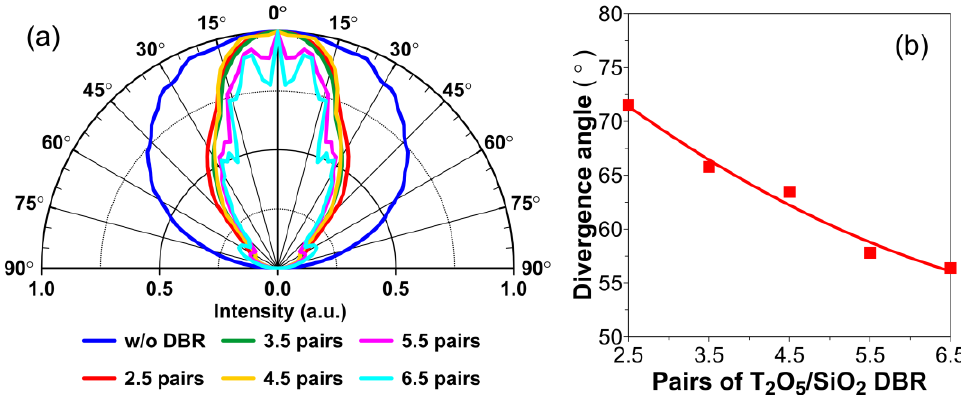
Figure 10. ( a ) Far-field emission patterns of the green μ-RCLEDs with staggered MQWs operating at 300 mA for different pairs of Ta 2 O 5 /SiO 2 DBRs. The blue line indicates the emission pattern of conventional LEDs. ( b ) Far-field divergence angle as a function of pairs of DBRs.